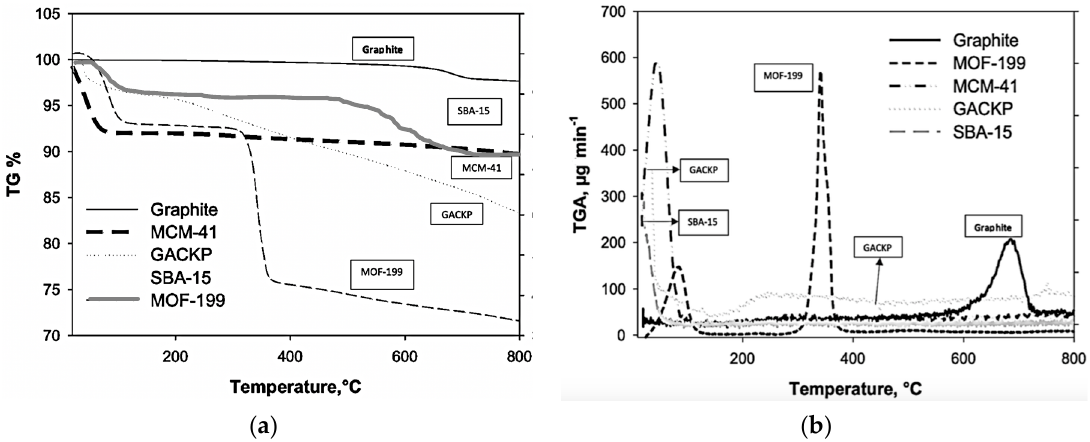
Figure 3. ( a ) TGA and ( b ) DTG of MOF-199, MCM-41, SBA-15, GACKP and Graphite.